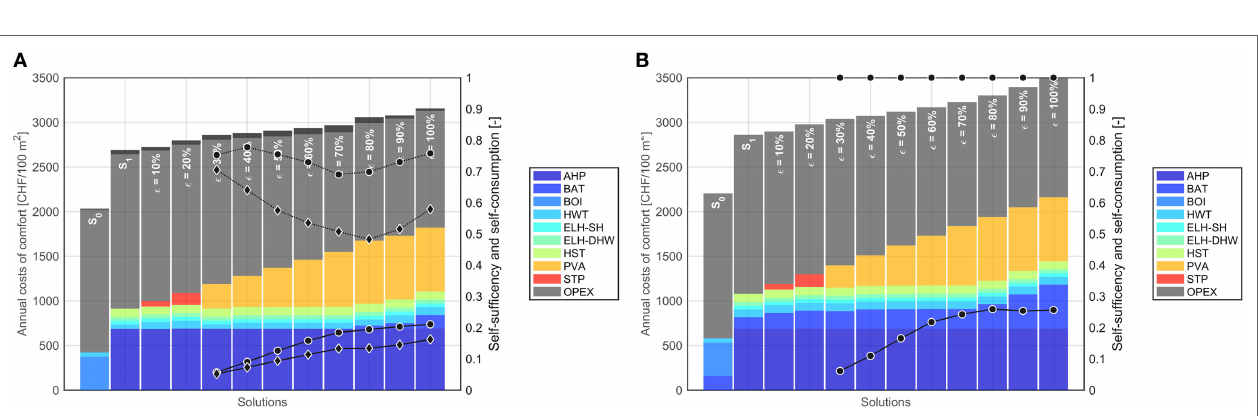
FIGURE 8 | Pareto fronts for a single-family home when applying MPC (circles), RBC (diamonds), and MPC with a tight GM constraint (squares).